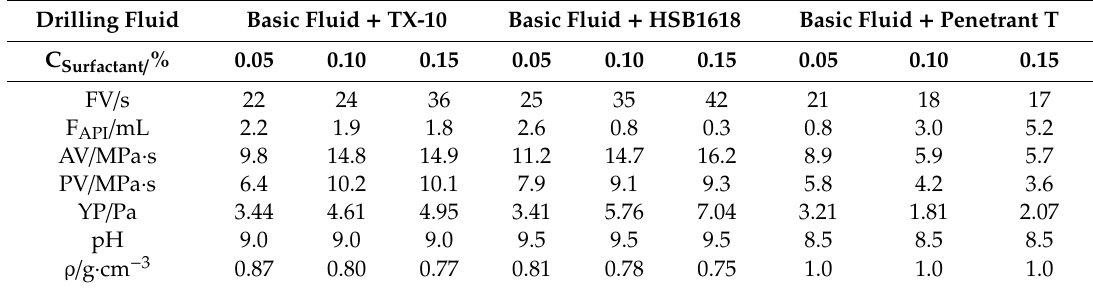
Table 2. The rheological properties of solid-free drilling